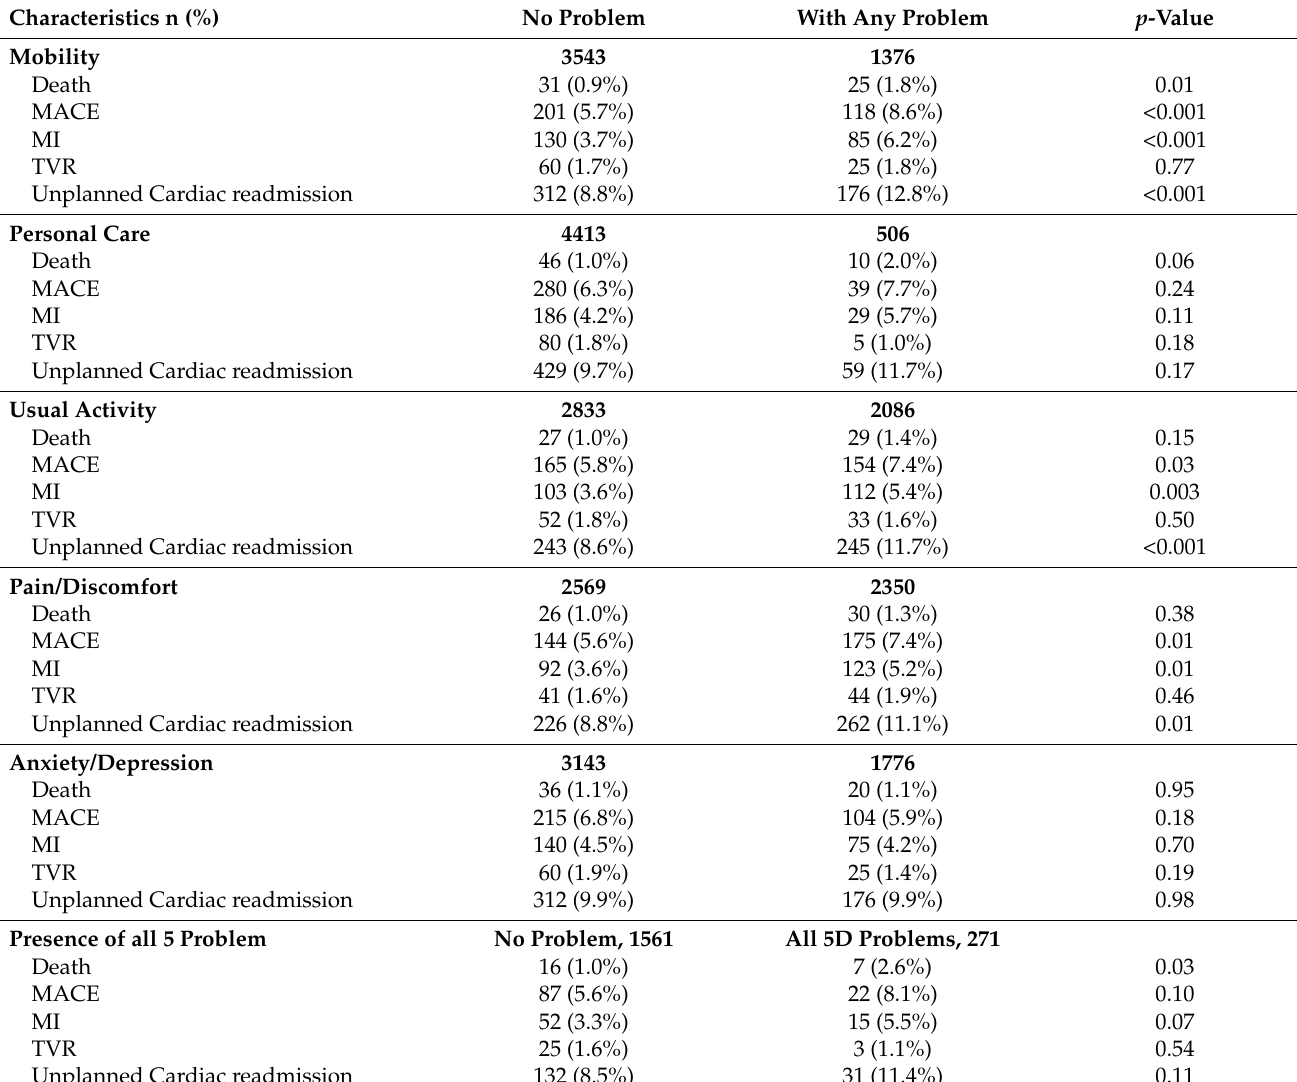
Table 4. Outcome (following procedure) by presence of problem among those with QoL information available and completed 1-year